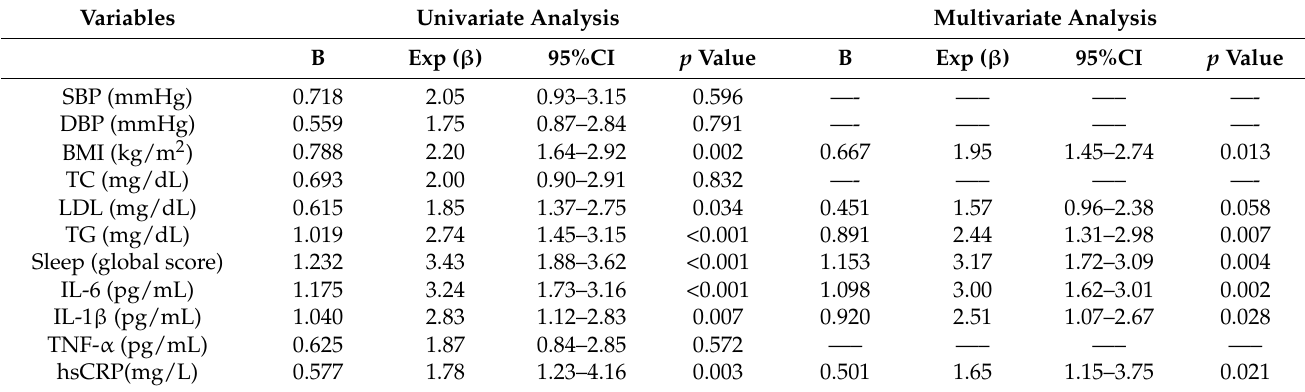
Table 2. Univariate and multivariate analysis of various variables associated with osteoarthritis risk. Variables Univariate Analysis Multivariate